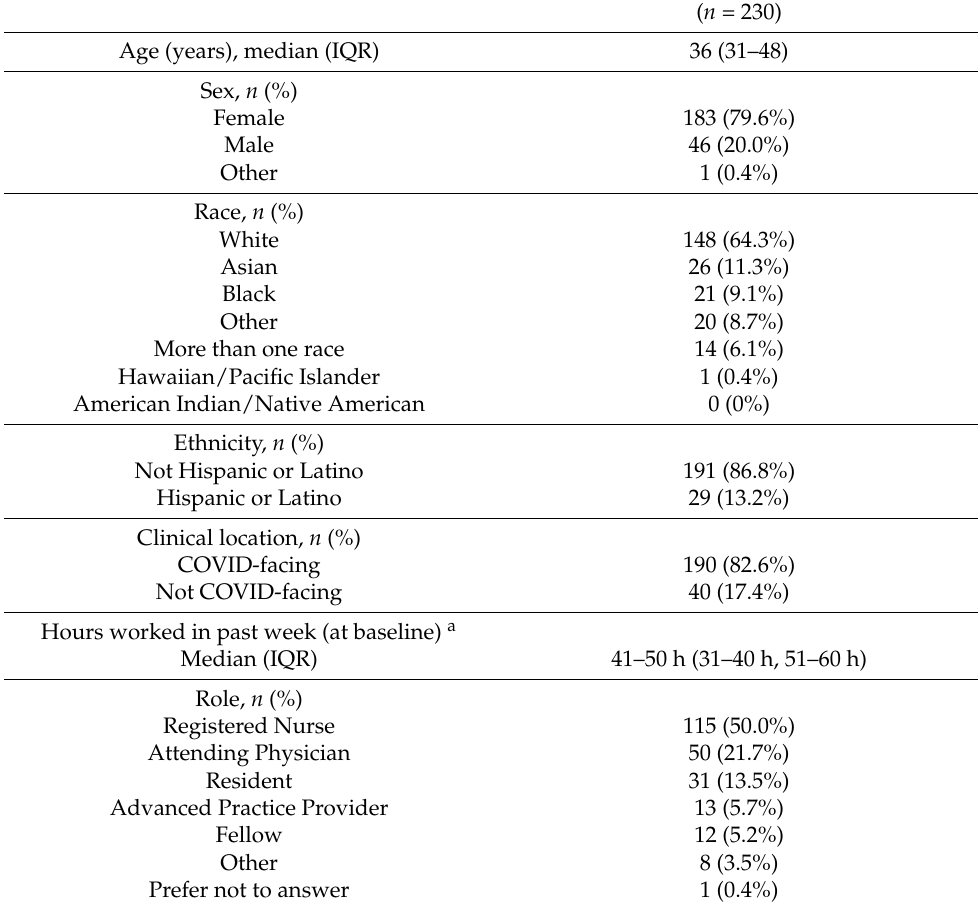
Table 1. Baseline characteristics of participants who agreed to participate in the longitudinal follow- up assessments ( n =